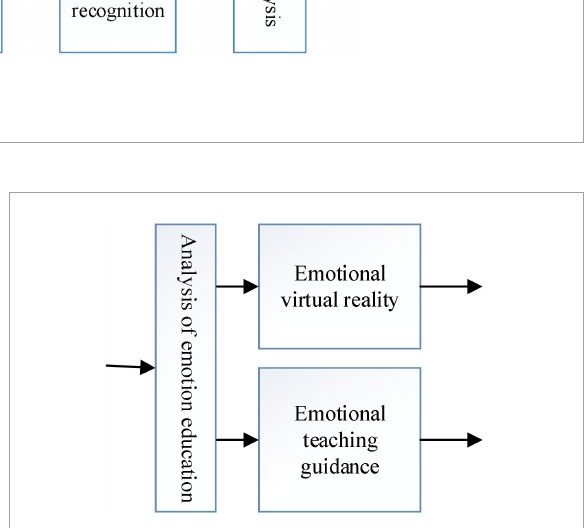
FIGURE5 Functional structure of the emotion assessment